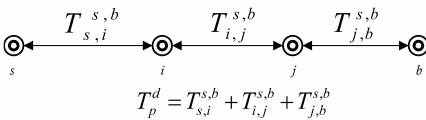
Figure 2. Propagation delay in multi-hop